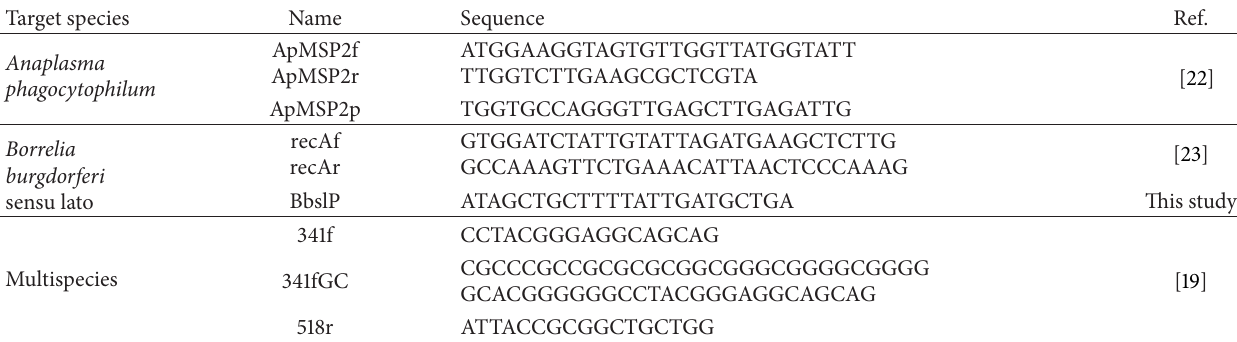
Table 1: List of DGGE primers, qPCR primers, and probes in 5 󸀠 to 3 󸀠